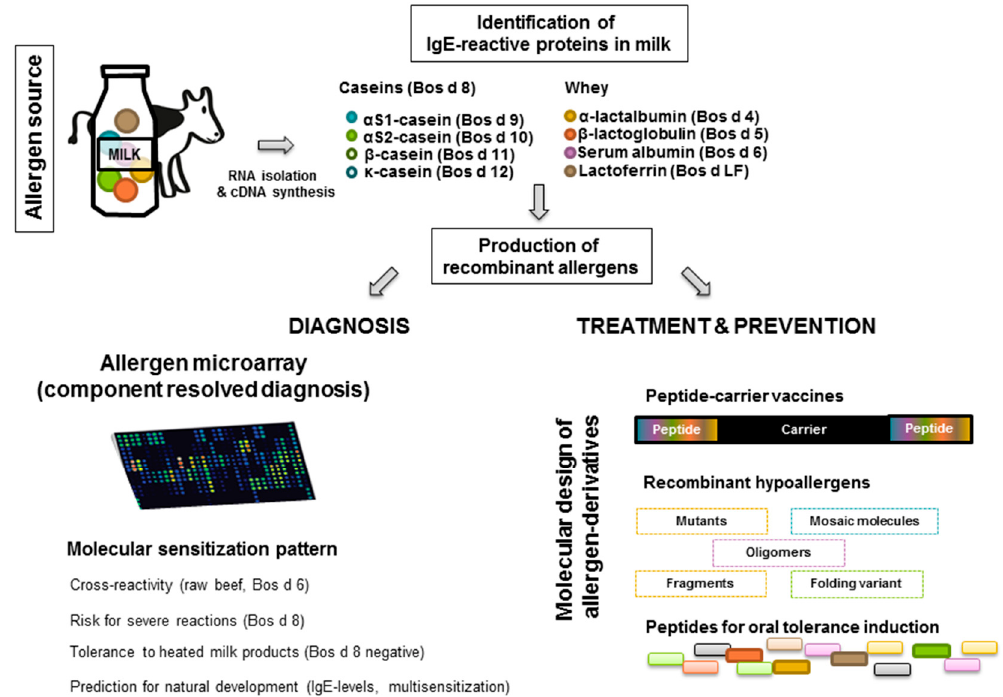
Figure 1. Component-resolved diagnosis, treatment, and prevention of cow’s milk allergy. Cow’s milk contains several allergenic molecules (components), which can be produced as recombinant proteins. Microarray technology allows determining reactivity profiles of patients and their sensitization to cross-reactive allergens and identifying individual allergens that cause disease. The severity of reactions and natural tolerance development can also be predicted. Based on the DNA sequences of cow’s milk allergens, molecules for treatment and prevention can be designed.